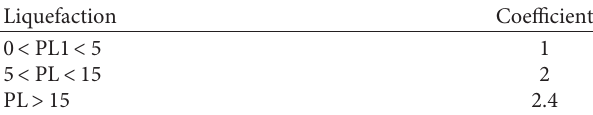
Table 8: Weighted coefficient for soil liquefaction.